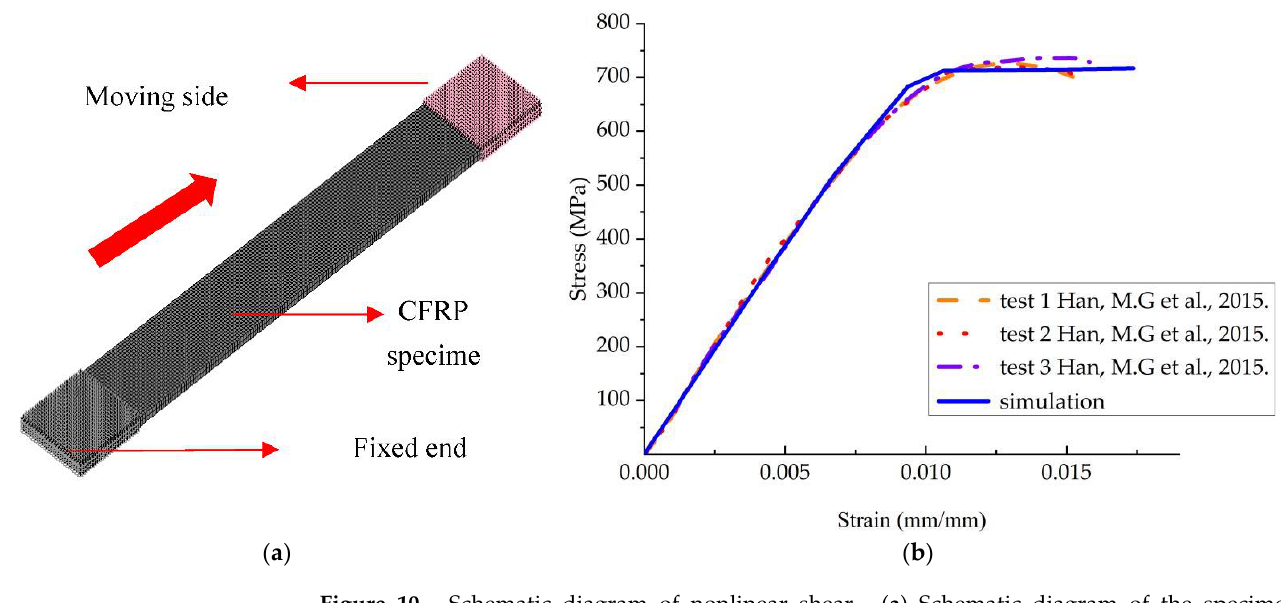
Figure 10. Schematic diagram of nonlinear shear. ( a ) Schematic diagram of the specimen; ( b ) specimen stress – strain curve [28].